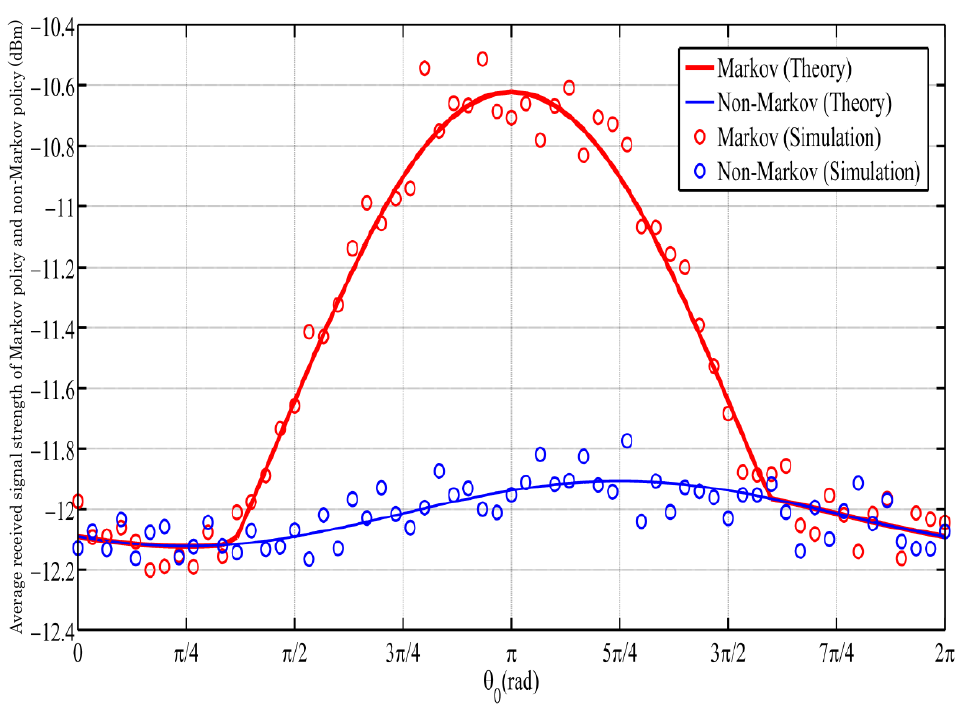
Figure 16. Average received signal strength of Markov and non-Markov